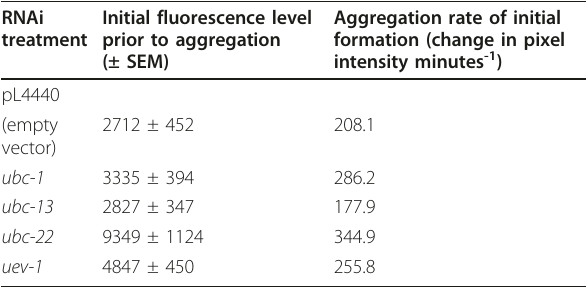
Aggregation rate of initial formation (change in pixel intensity minutes -1